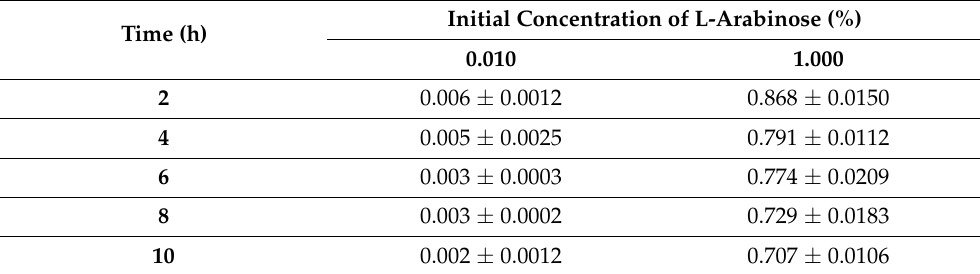
Table 5. Determination of L-arabinose consumption during the bioreactor induction step.